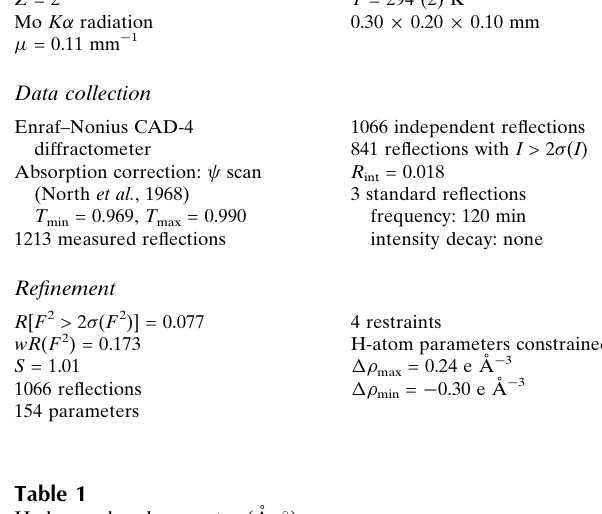
Hydrogen-bond geometry (A˚ , (cid:2)